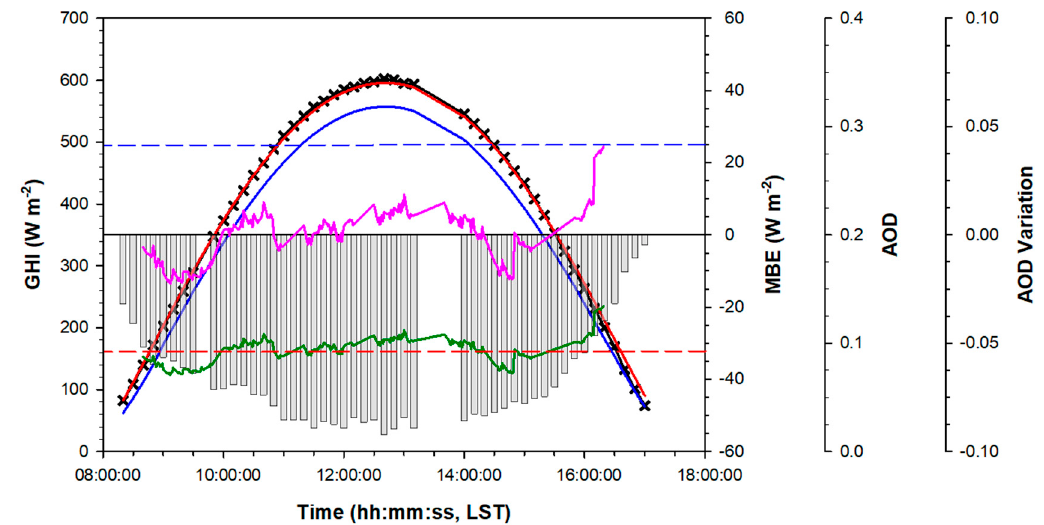
Figure 10. Same as Figure 9 except on 19 January 2021.